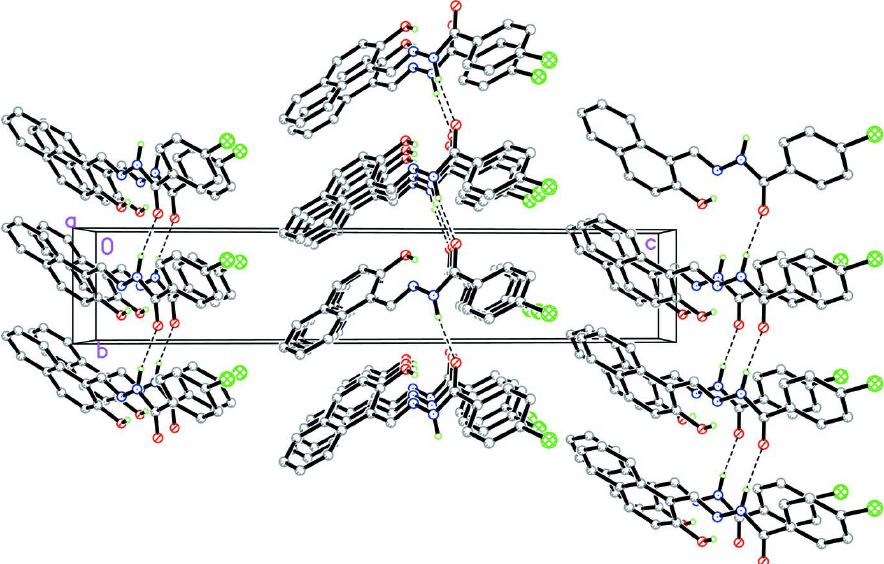
Figure 2 Crystal packing packing of the title compound, viewed along the a axis. H atoms not involved in hydrogen bonding (dashed lines) have been omitted for